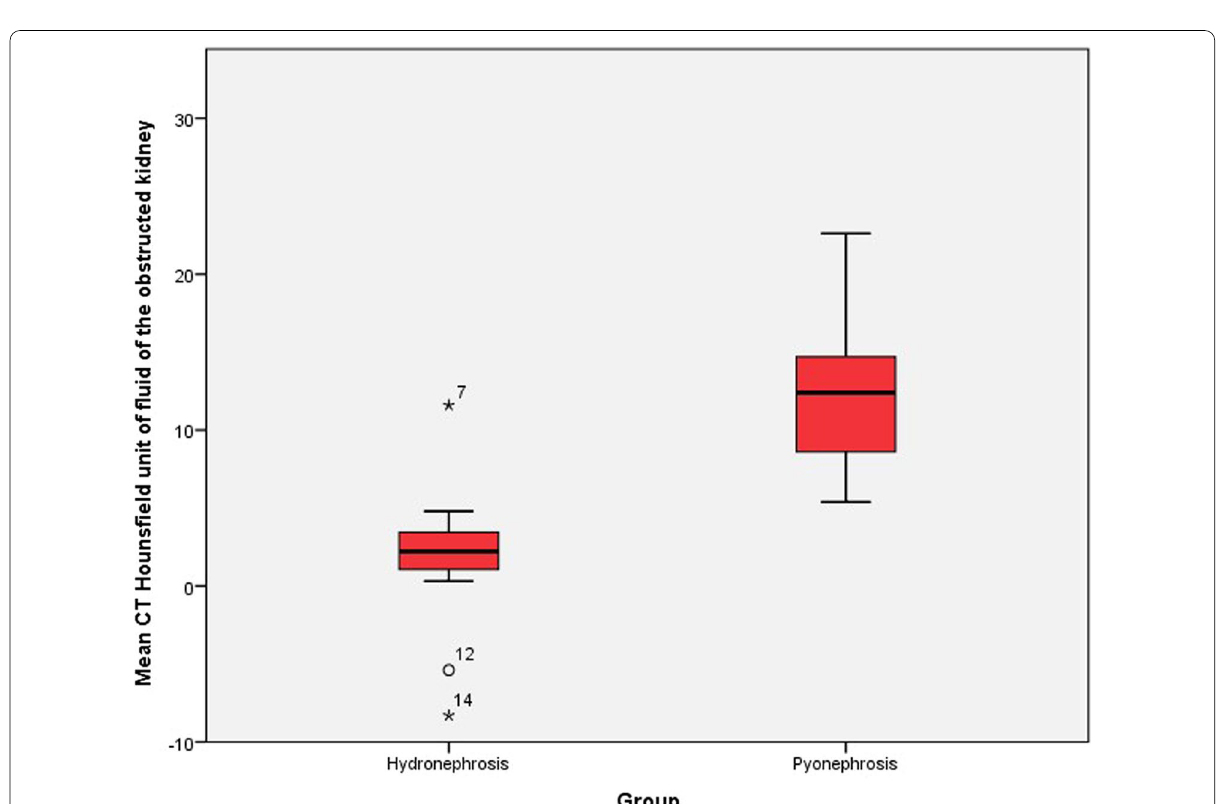
Fig. 2 Box plot showing Hounsfield units distribution among study